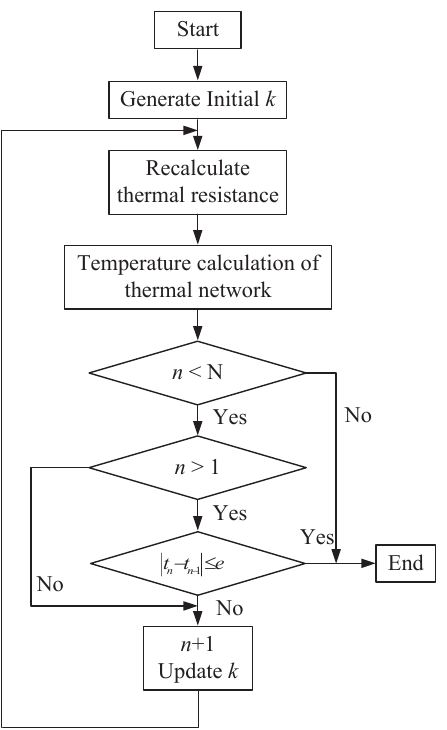
Figure 5. The flow chart of the iterative